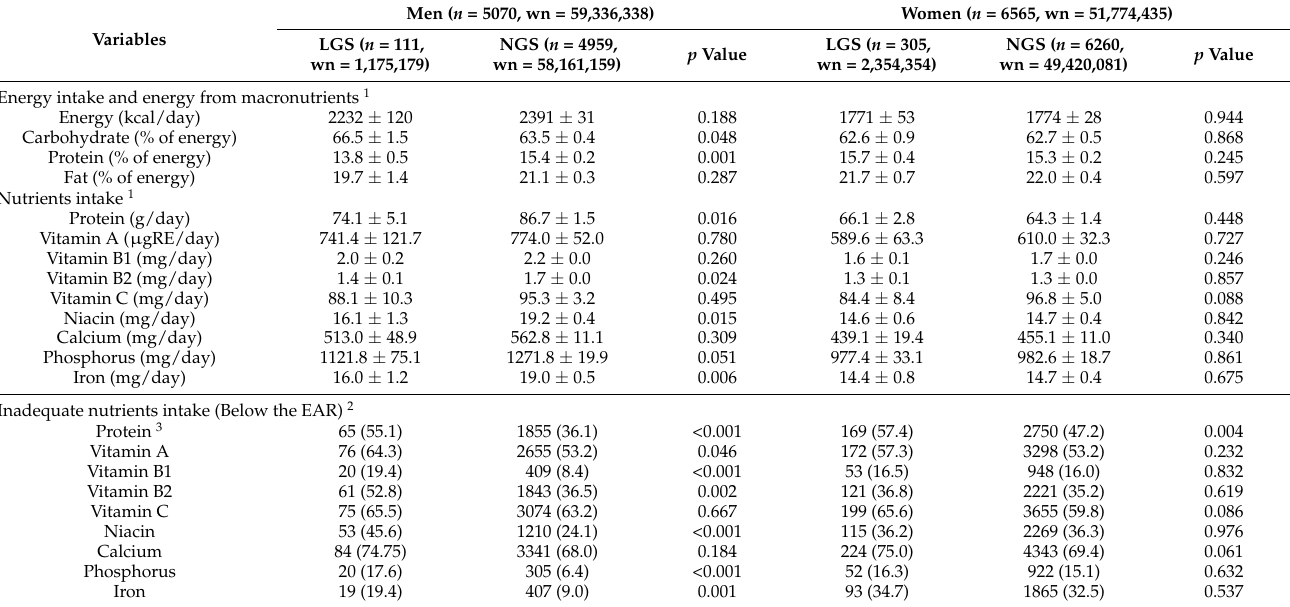
Table 2. Assessment of dietary intake and adequacy of nutrients intake of the